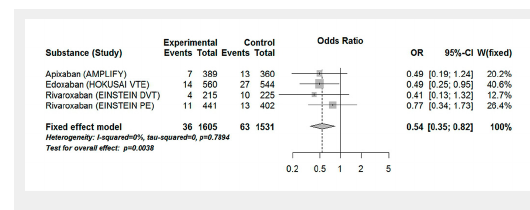
Figure 7 Forest plot of composite endpoint recurrent VTE or VTE-related death in patients with VTE aged 75 years or over. CI = confidence interval; experimental = direct oral anticoagulants; control = vitamin K antagonists; DVT = deep vein thromboembolism; PE = pulmonary embolism; VTE = venous thromboembolism